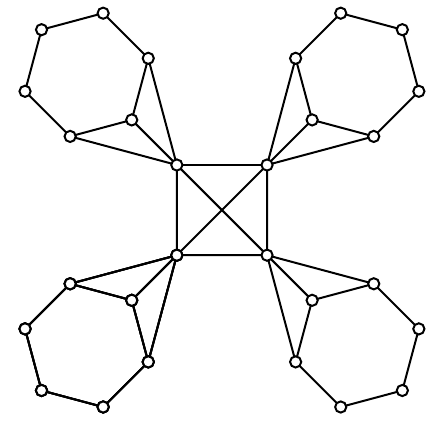
Fig. 2: The graph G 4 that attains the bound from Corollary